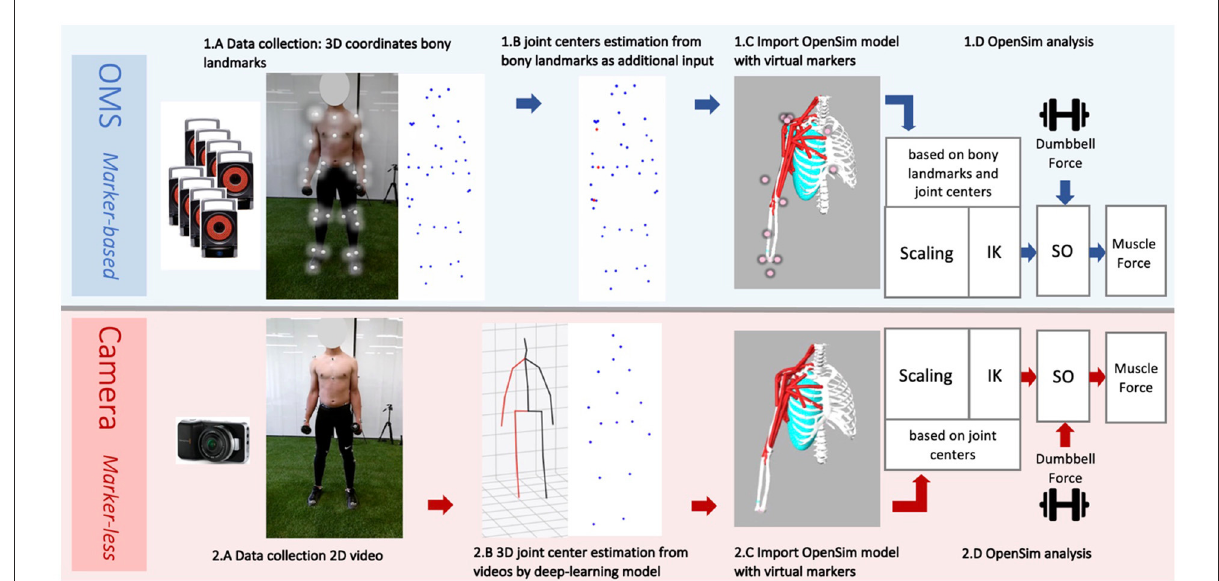
FIGURE2 Workflow data collection and analysis from the marker-based optolectronic measurement system (OMS) (top) and the markerless camera (bottom) methods. The OMS consisted of 8 infrared cameras that captured the 3D trajectories of reflective markers placed on bony landmarks of the participant (1.A) . Additionally, joint center trajectories were estimated from bony landmarks and added to the data (1.B) , before importing in OpenSim. The generic thoracoscapular model with virtual markers (pink) that corresponded to locations of the collected bony landmarks and joint centers (experimental markers) (blue and red) was imported in OpenSim (1.C) . The camera captured standard 2D videos of the participant from a frontal view (2.A) . A deep-learning model (8) was employed to obtain 3D joint center trajectories from these videos (2.B) , which were subsequently imported into OpenSim. The generic thoracoscapular model was also imported in OpenSim with virtual markers (pink) (difficult to see in the figure as these are located within the joints) that corresponded to locations of the joint centers (experimental markers) (blue) (2.C) . The OpenSim pipeline was almost the same for both methods (1.D and 2.D) , including the steps: scaling, inverse kinematics (IK) and static optimization (SO) (with the external dumbbell force as additional input). The only difference was that for scaling and IK, experimental